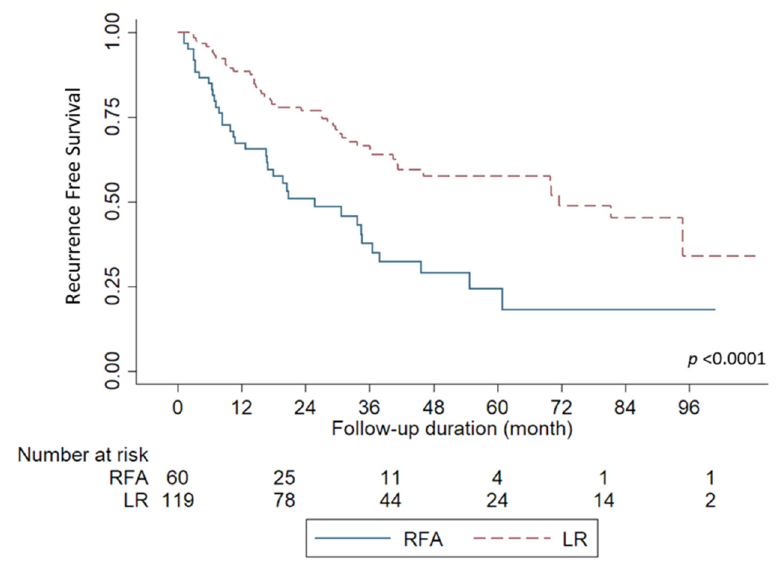
Figure 1. Comparison of recurrence-free survival based on the treatment modalities. Liver resection (LR) showed a significantly better survival curve over radiofrequency ablation (RFA) for patients ( p < 0.0001).